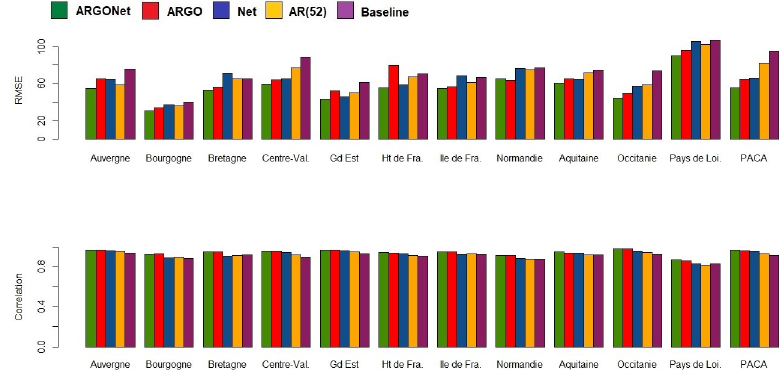
Fig 2. Visualization of correlation and errors obtained for real-time estimate with each